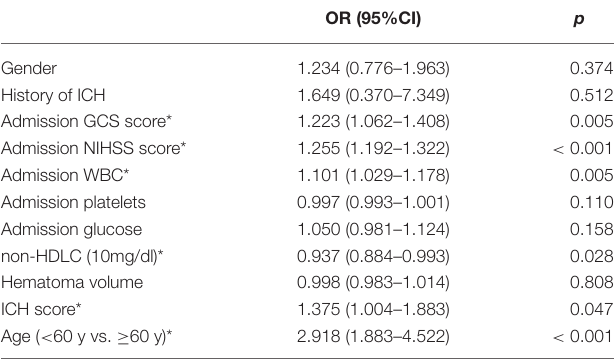
TABLE 4 | Multivariate-adjusted # OR and 95% CI for poor outcome (mRS ≥ 3) according to every 10 mg/dl of